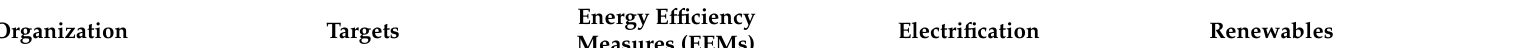
Table 5. Climate targets and approaches toward achieving net zero goals globally and by China, the EU, and the